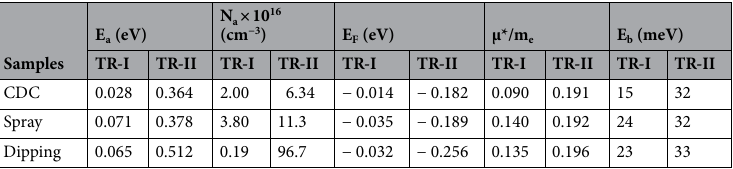
Table 2. The acceptor ionization energy (E a ), acceptor density (N a ), Fermi level (E F ), excitonic reduced effective mass (μ*) and excitonic binding energy (E b ) of charge carrier for CDC, spray and dipping